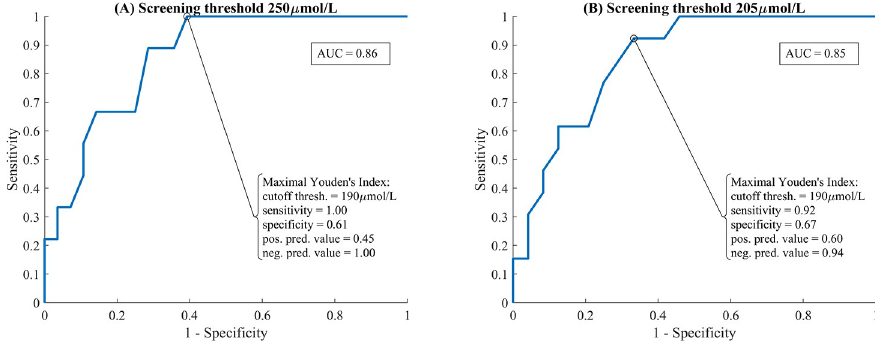
Fig 6. Receiver operating characteristic plots screening TSB at two thresholds using SCB xy as the decision metric. (A) Screening threshold of 250 μ mol/L. (B) Screening threshold of 205 μ mol/L.